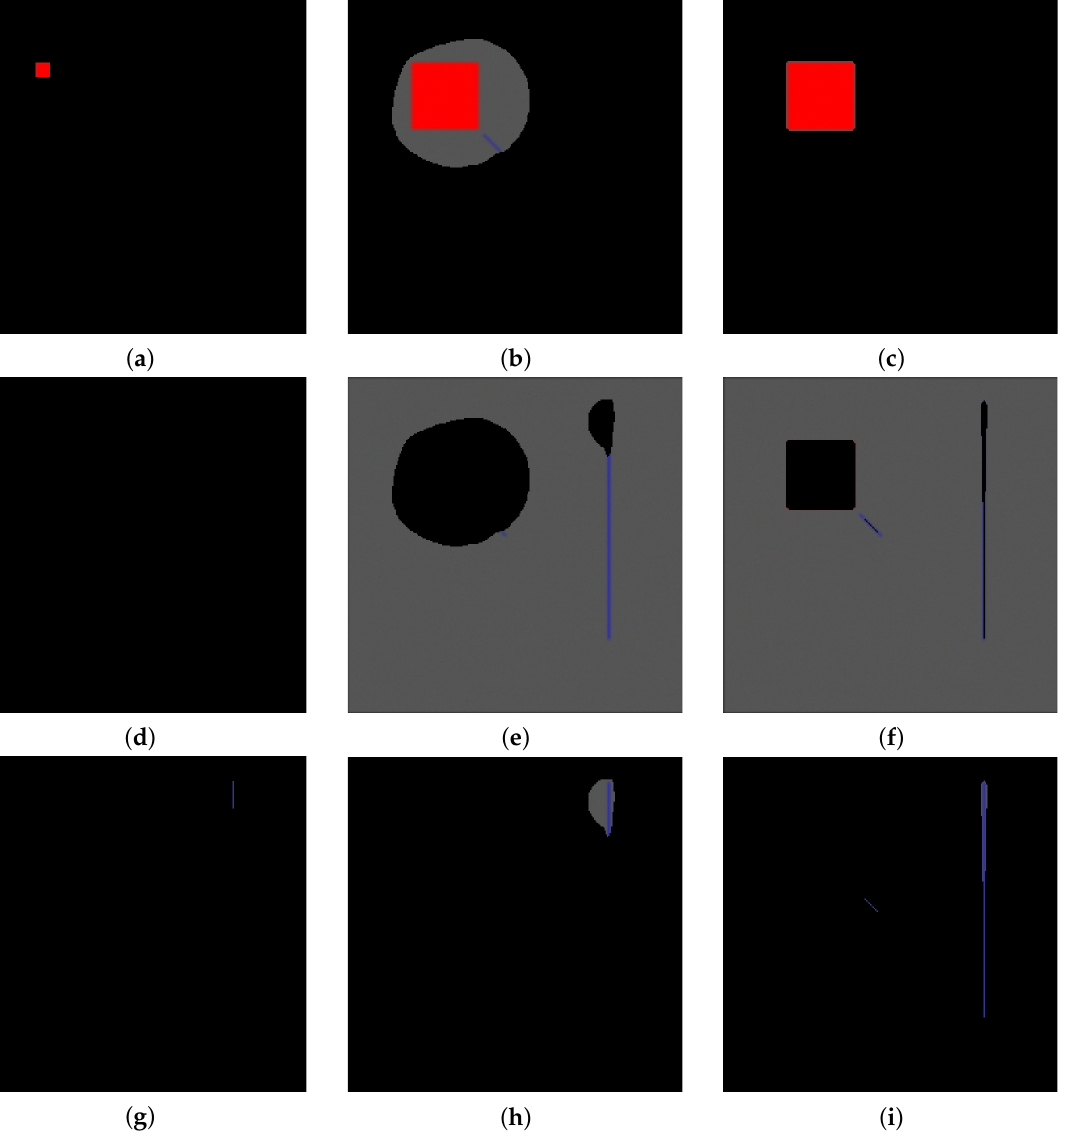
Figure 5. Comparison between simple labelling using the diffusion process and the proposed procedure. ( a , d , g ) refer to marked red, blue, and background regions, respectively. ( b , e , h ) refer to the labelled regions by employing only the diffusion process ( α = 0, β = 1). ( c , f , i ) show the results of the proposed procedure ( α = β = 1) for each